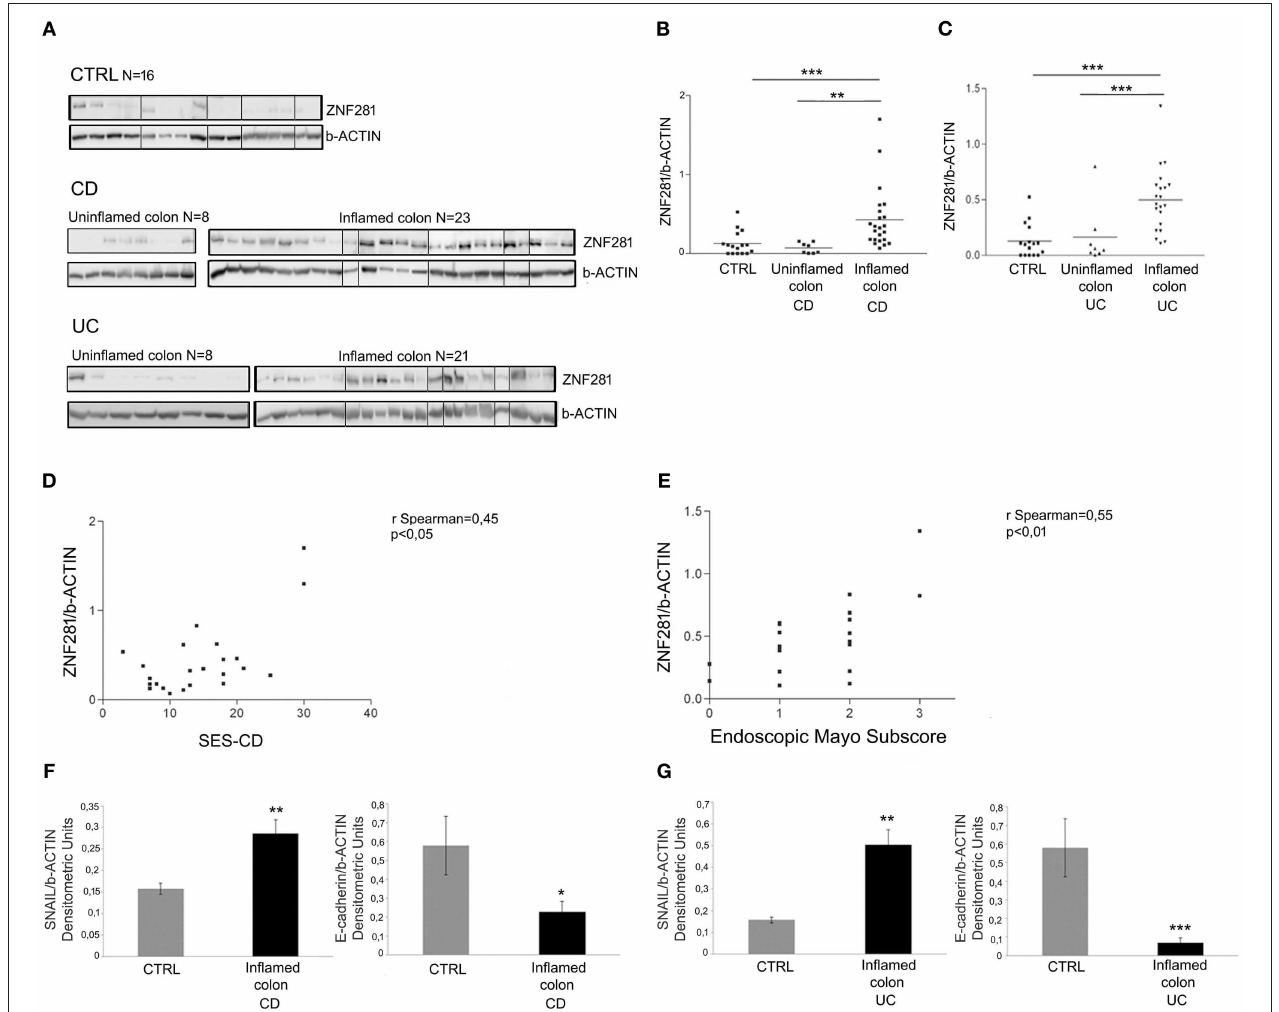
FIGURE 2 | ZNF281 is increased in the inflamed colonic tissues of CD (A,B) and UC (A,C) pediatric patients as compared to uninflamed colonic samples and to controls (CTRL) (different gels were indicated); positive correlation between SES-CD, Mayo subscore and ZNF281 protein expression (D,E) ; SNAIL protein expression is significantly increased and E-cadherin level decreased in inflamed colonic tissues of CD (F) and in UC (G) patients as compared to CTRL. Densitometric analysis is showed. Data represent the target gene expression normalized to the reference gene. Data are presented as mean ± S.D. of bioptic sample analyses from CD patients ( N = 23), UC patients ( N = 21)and age matched CTRL ( N = 16). CTRL, controls; CD, Crohn Disease; UC, Ulcerative Colitis; SES-CD, Simple Endoscopic Score for Crohn’s Disease. Mann–Whitney t -test; Spearman’s rank correlation coefficient. * P < 0.05; ** P < 0.01; *** P <